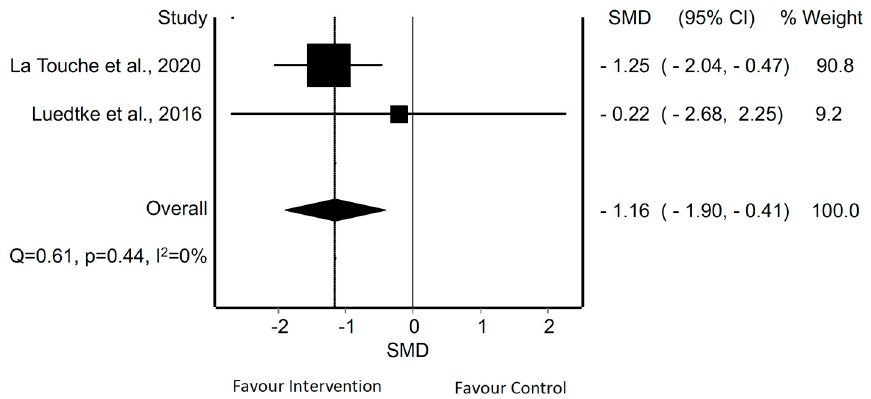
Figure 5. Synthesis forest plot for pain intensity in patients with migraine treated with aerobic exercise. The forest plot summarizes the results of included studies (review size, standardized mean differences [SMDs] and weight). The small boxes with the squares represent the point estimate of the effect size and sample size. The lines on either side of the box represent a 95% confidence interval (CI).